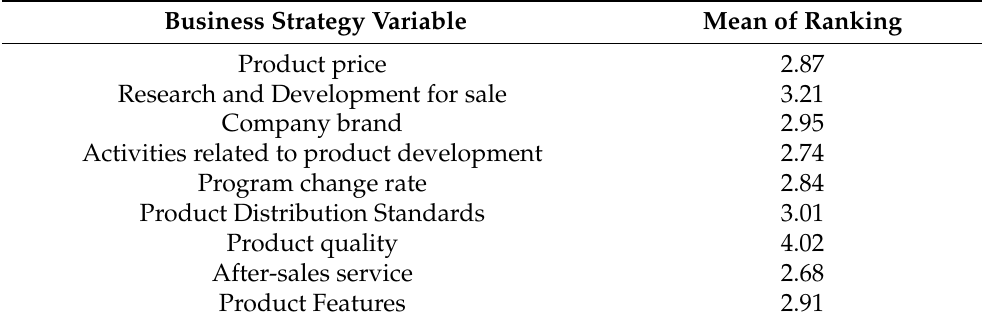
Table 14. Mean of ranking in tested dimensions in business strategy variable based on Kruskal– Wallis